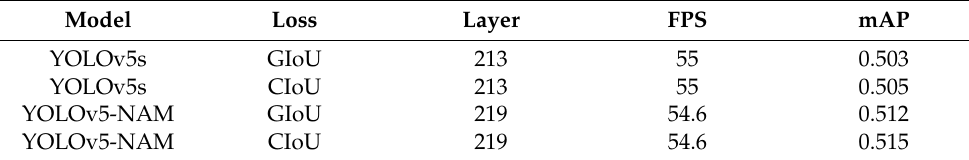
Table 2. The influence of loss